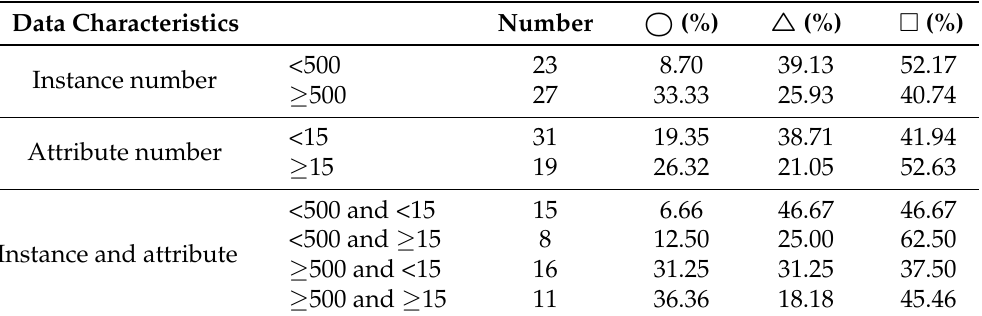
Table 15. The relationship between the regulatory factor β in ATFNB and the characteristics of the dataset.